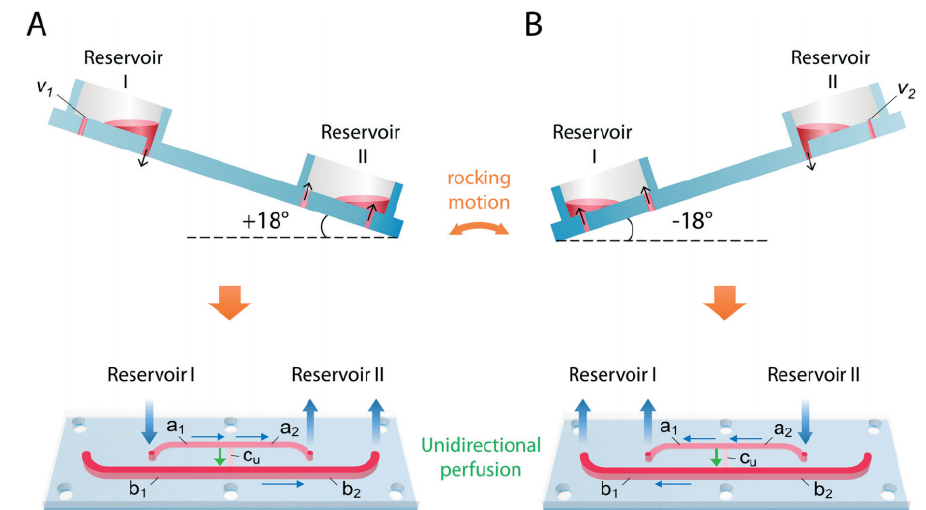
Figure 3. Schematic of UniChip operation. A demonstration UniChip is placed on a rocker platform that flips, tilting between +18° (A) and −18° ( B ) periodically. When tilted at +18° ( A ), flow in b1 is halted by the capillary force at the air–liquid interface in the passive valve v1. Flow is directed from reservoir I through a 1 , a 2 , Cu, and b 2 into reservoir II. When tilted at −18° ( B ), flow in b 2 is halted by valve v 2 , and flow is directed from reservoir ii through a 2 , a 1 , Cu and b 1 into reservoir II. Under either condition, the flow direction in the cell perfusion channel, Cu, is kept the same, as shown by the green arrows. Reproduced from [78], with permission from the Royal Society of Chemistry,